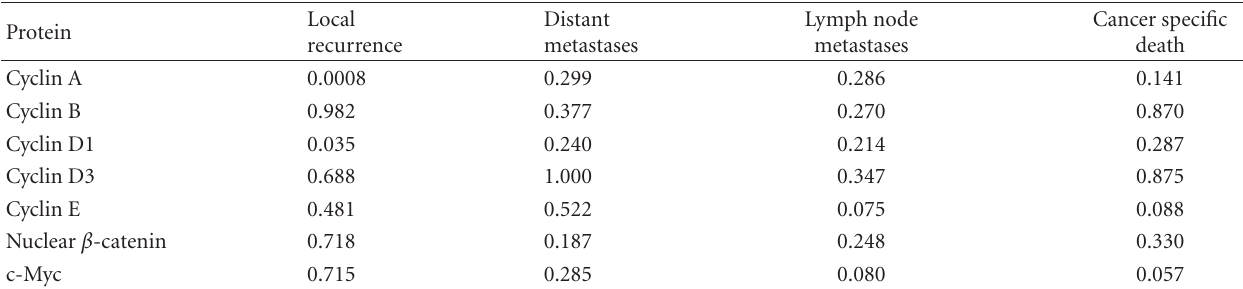
Table 8: Cross table with Fisher’s exact test. P -values without Bonferroni correction.